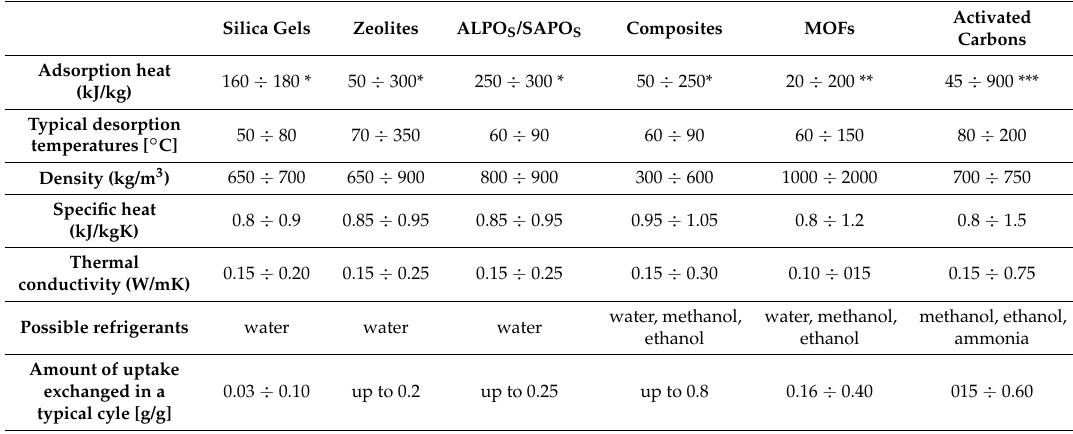
Table 1. Main properties of sorbent material